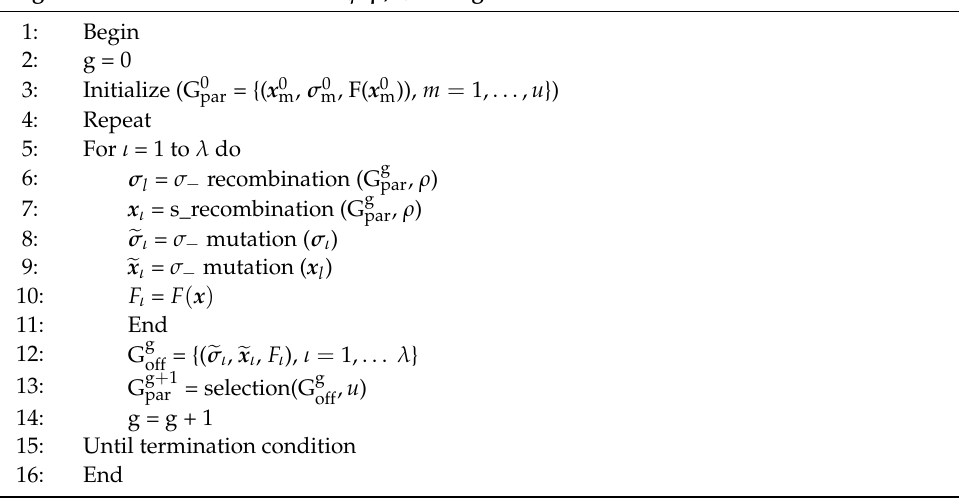
Algorithm 1: Pseudo-code of the ( µ / ρ , λ )-ES